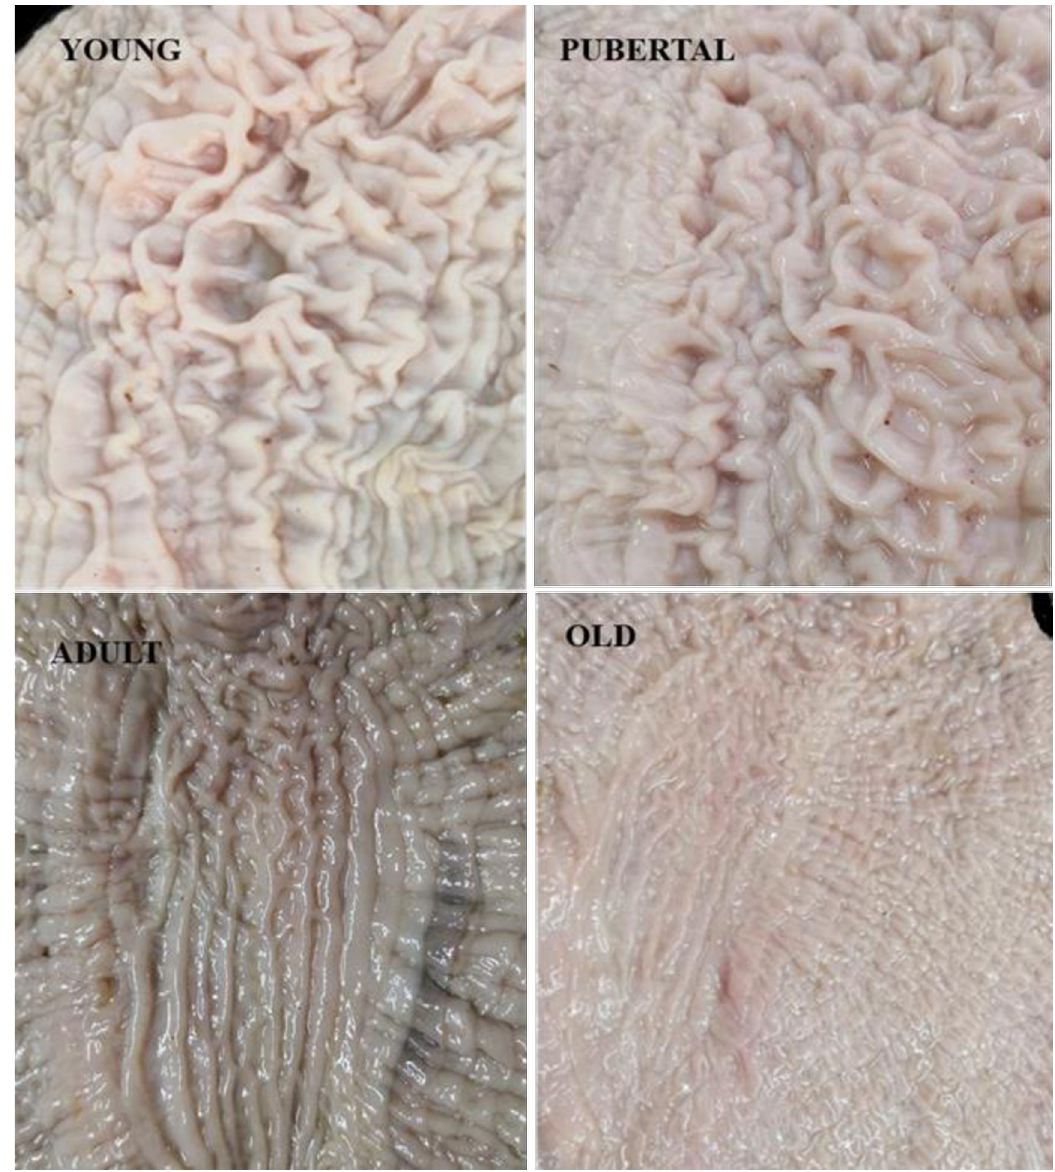
Fig 3. The reticular area of ALNA with a grid-like appearance. Young: 1 year old; pubertal: 5 years old; adult: 12 years old; old: 19 years old.